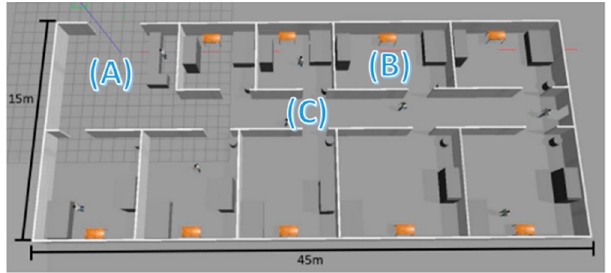
Figure 6. Map of the scenario #1 — hospital: reception ( A ), room ( B ), and corridor ( C ).